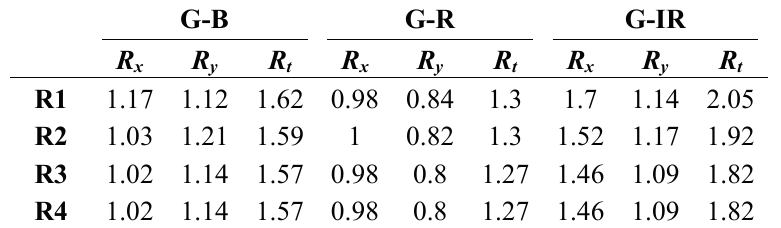
Table 2. The errors for registering near infrared, red and green band to the blue